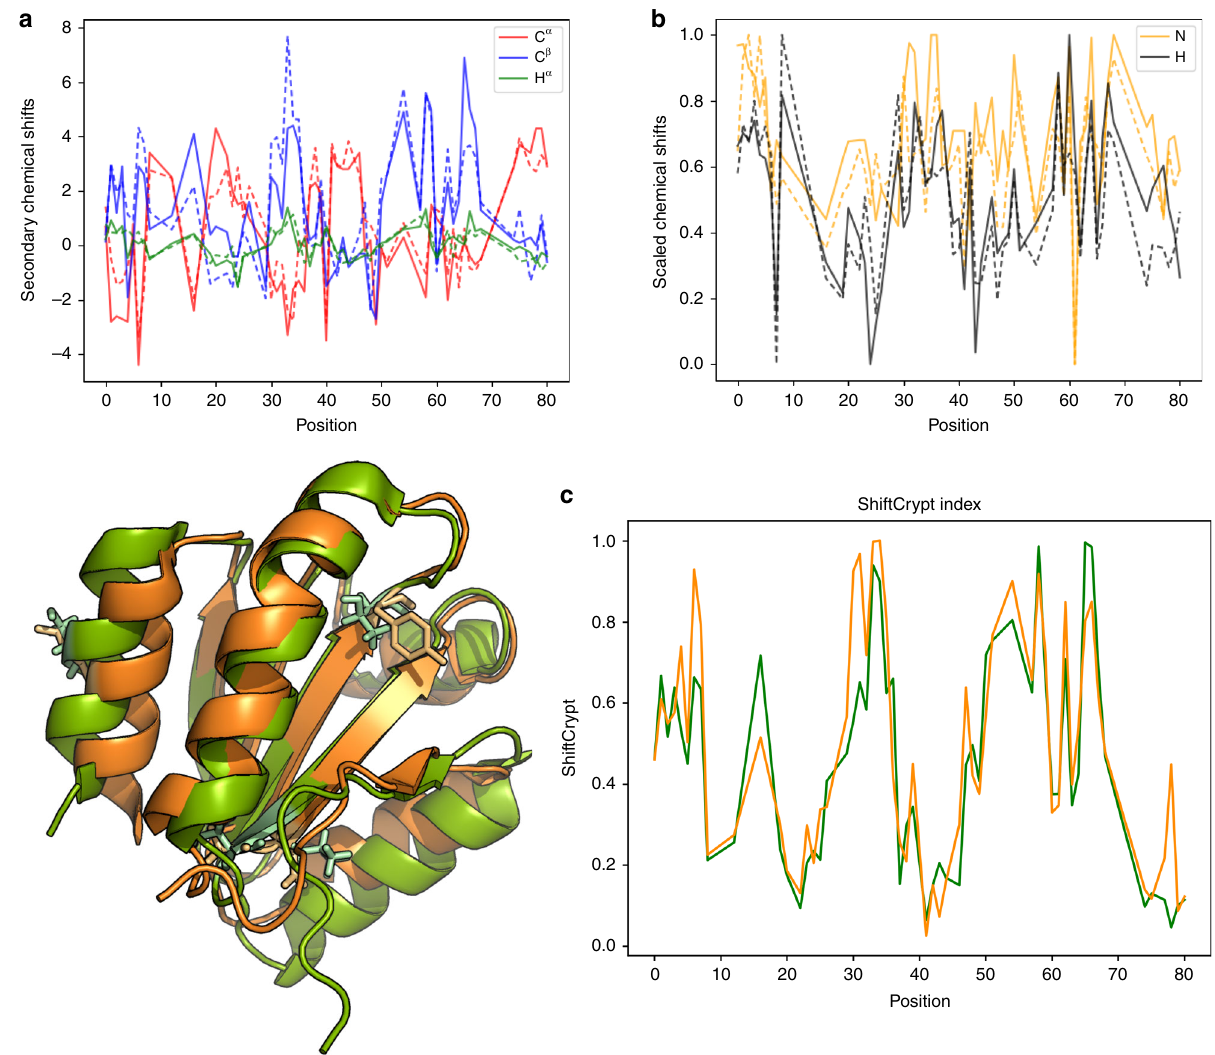
Fig. 4 Detection of a remote homology using chemical shifts. Panel a shows the C α (red), C β (blue), and H α (green) secondary chemical shifts, while panel b the N-scaled (yellow) and H-scaled (black) scaled chemical shifts for the oxidized thioredoxin 1 of A. thaliana (full line) and S. cerevisiae (dotted line), which share 46% sequence identity. The ShiftCrypt index ( c ) and superimposed structures are also shown for A. thaliana (green) and S. cerevisiae